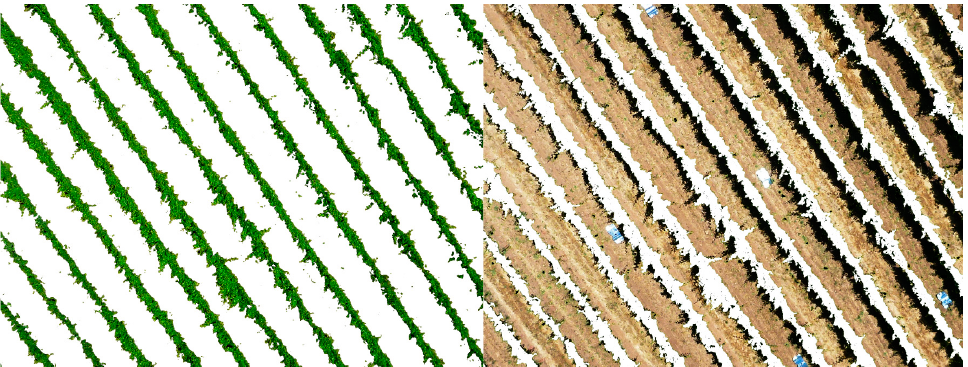
Figure 3. UAV image masked using the result of the 2G_RBi classification method.